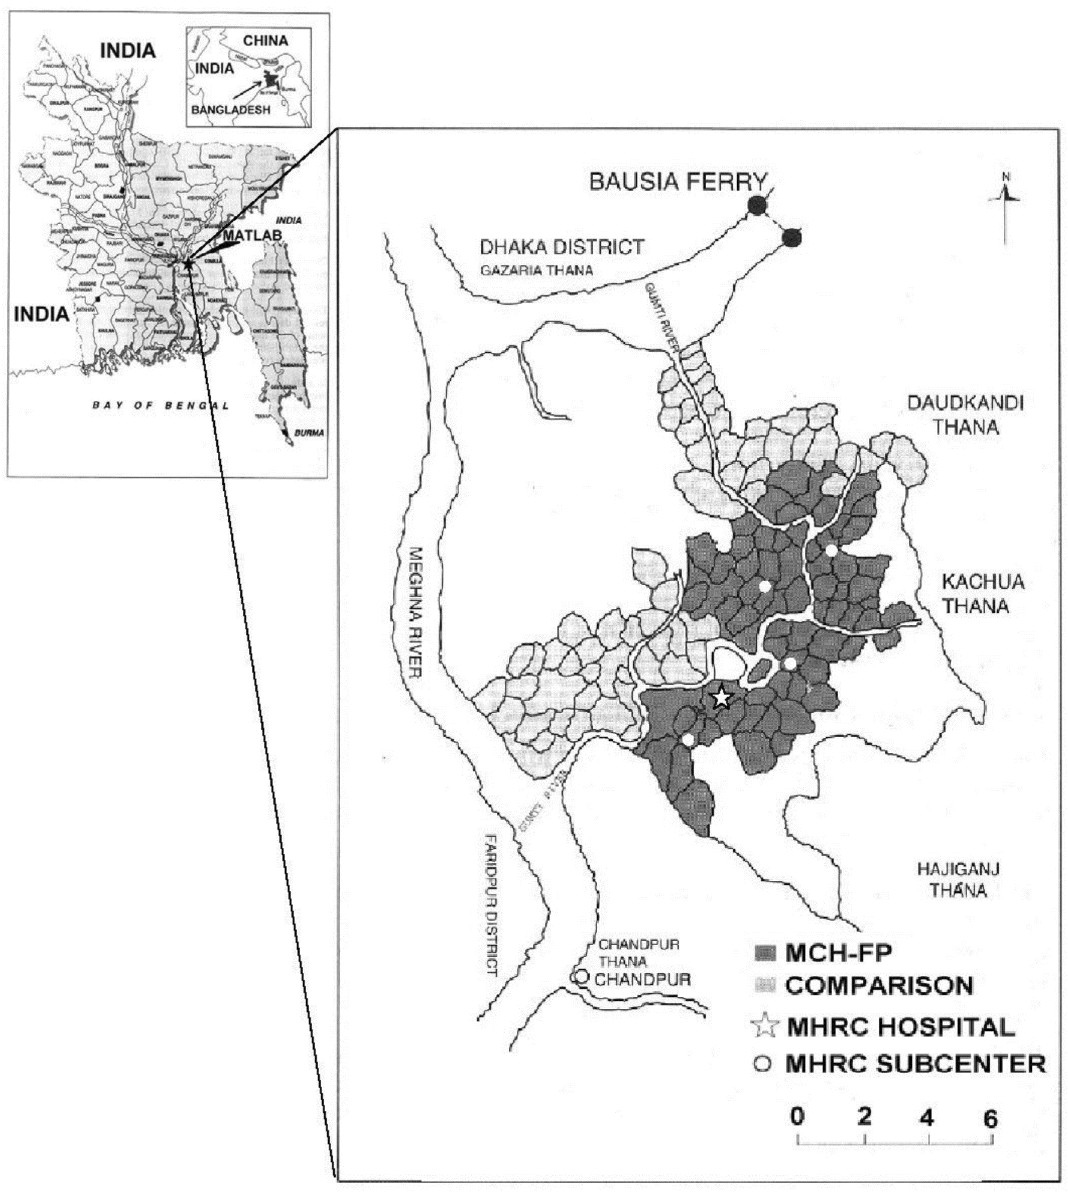
Figure 1. Geographic location and layout of the ICDDR,B Matlab Health Research Center. * *Modified, with permission, from Canada’s International Development Research Center, www.idrc.ca and the ICDDR,B [52].